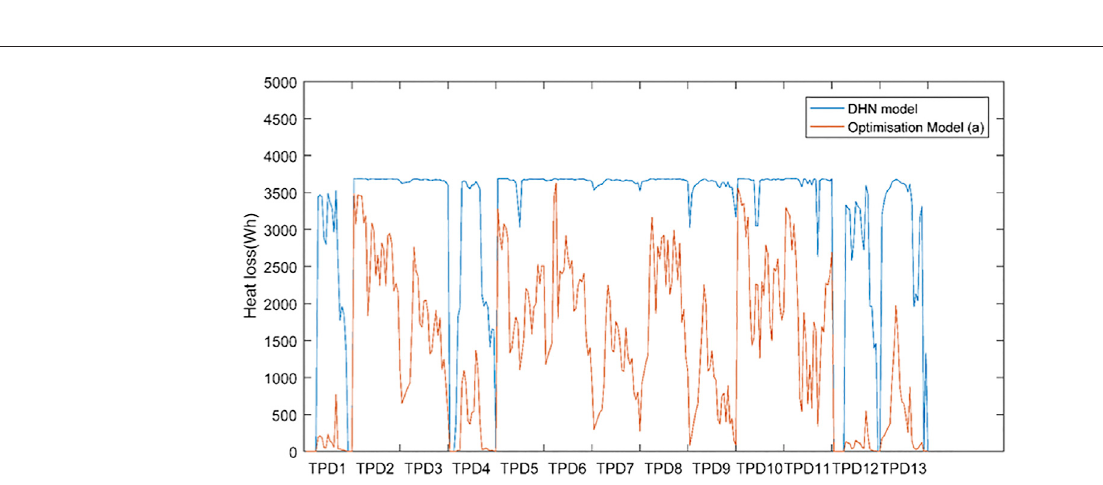
FIGURE 6 | Network layout and annualized investment costs in